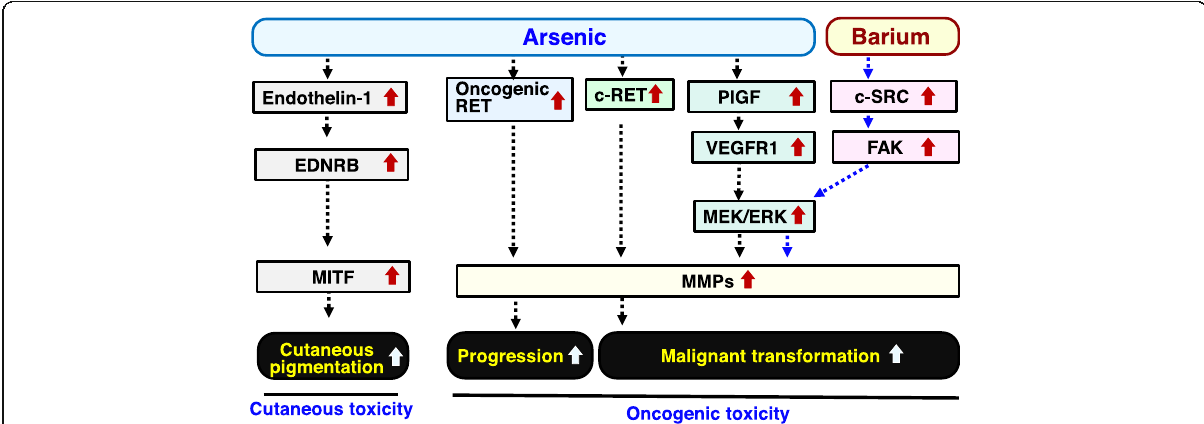
Fig. 2 Biochemical analyses of cutaneous and oncogenic toxicities of arsenic and barium. Arsenic and barium may promote the development of hyperpigmented skin and malignant transformation and progression via activation of various intracellular signal transduction molecules. EDNRB